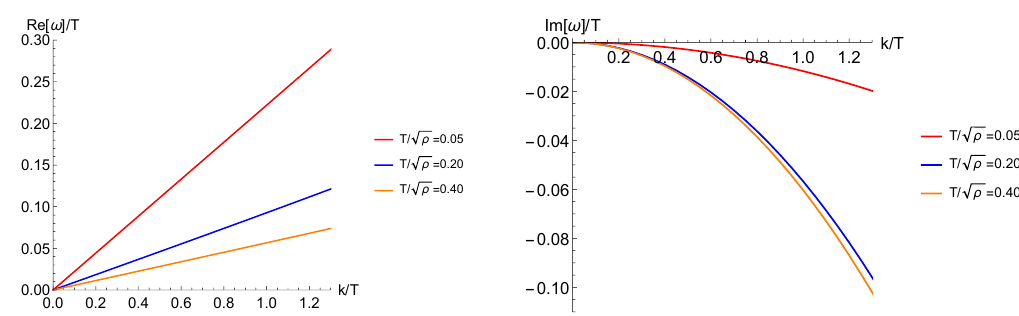
a + ic b to 1 k 2 k